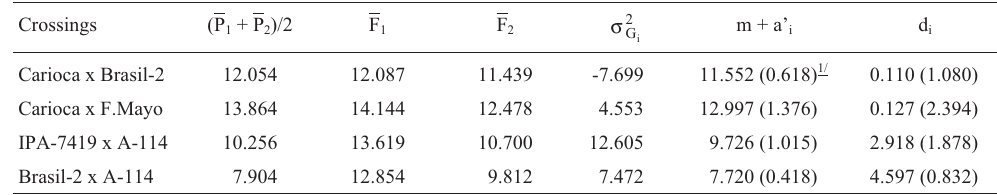
Table II - Mean yield, in g/plant, of the parents, F nents (m + a’ i and d i ) of each i